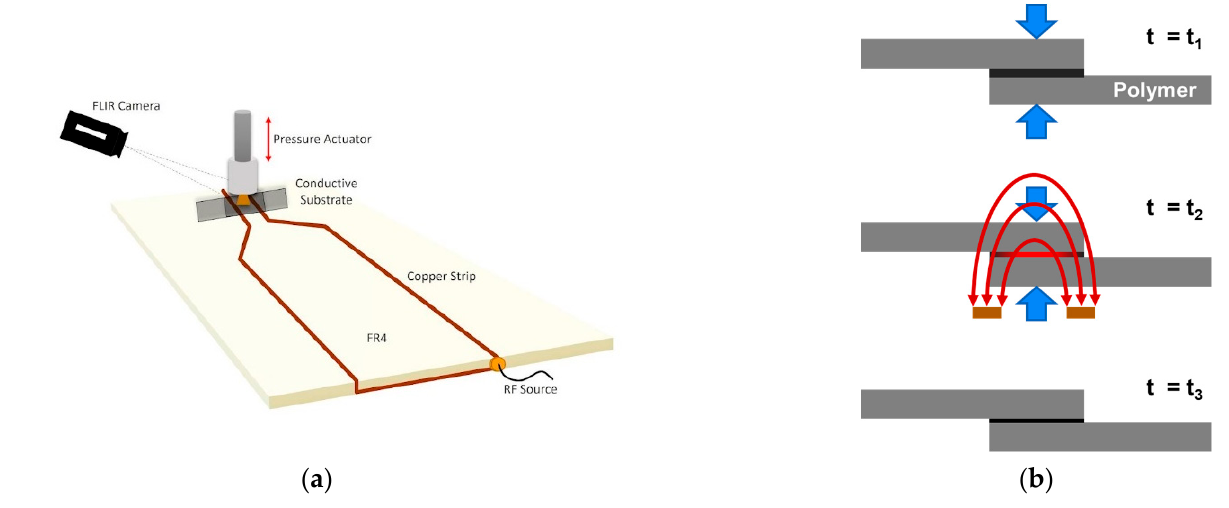
Figure 2. ( a ) RF heating setup with a coplanar RF applicator made from FR4 sheets. The specimens are placed at the end of the applicator as a pressure actuator presses on the two coupons. ( b ) Schematic shows conductive graphitic material heated by RF fields, leading to targeted heating and double-sided welding of two thermoplastic substrates. The black interlayer denotes the graphitic coating, red arrows show the fringing RF fields, and the blue arrows show the applied pressure (or displacement). Note that t 1 , t 2 , and t 3 are three time instances as the RF welding progresses.